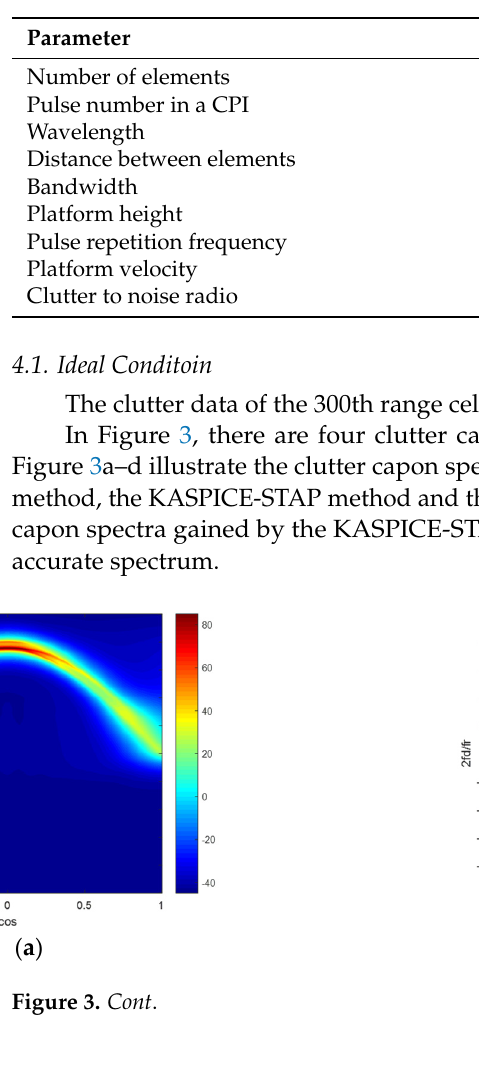
Table 1. Radar system parameters.